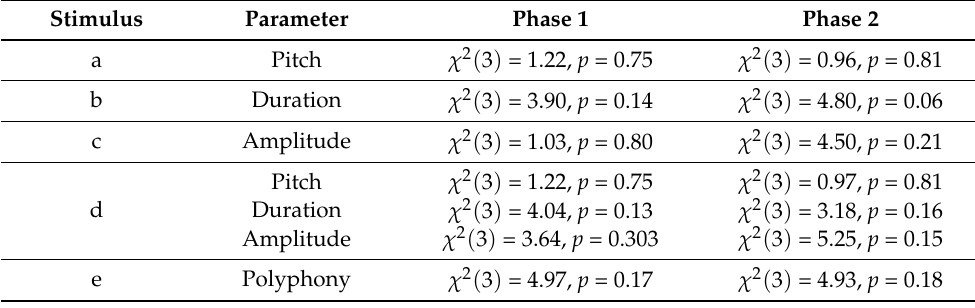
Table A29. Categorized gesture mappings profile